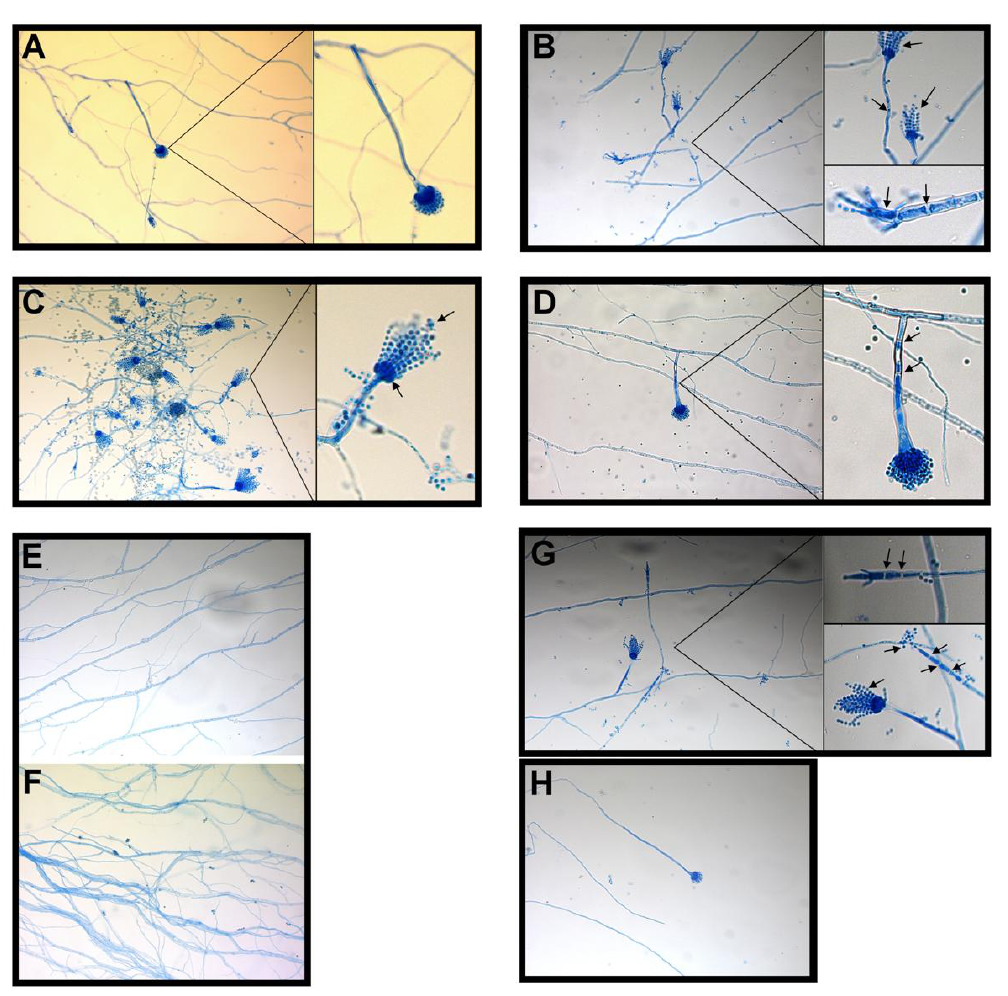
Figure 5. Lactophenol cotton blue preparation of a slide culture of A. fumigatus (original × 200). Images of intact structures of normal and mutation (treated with BER at 1/2 MIC plates) strains of A. fumigatus using an Axiovert 200 MAT microscope (Zeiss, Germany) by slide culture techniques at 3 day ( A ). Microscopic view of A. fumigatus showing typical columnar, uniseriate conidial heads. A. fumigatus grows at 45 °C. Note the conical-shaped terminal vesicles supporting a single row of phialides on the upper two-thirds of the vesicle. Vesicles are uniseriate and are covered by phialides / conidia on only the distal half. Conidia arise in chains and tend to sweep toward the central axis ( B , C , G ). Strains treated with BER (at the 1/2 MIC ) showing the appearance of a septum in the conidiophores ( B , D , G ), 50 elongation ( G , H ), and distortion of conidial heads and obscuration of metulae and phialides ( B , C , G ). Some mycelia were wreathed and some phialides arose circumferentially and were biseriate or uniseriate, with circumferential conidia obscuring vesicles ( E , F